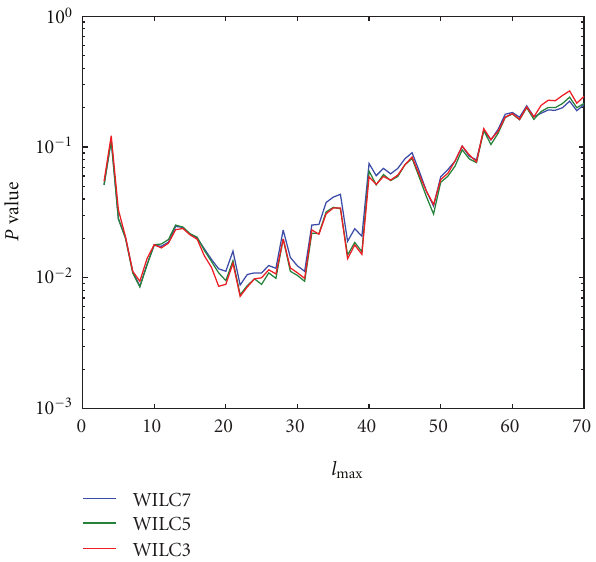
Figure 8: Probability of getting P + /P − as low as the ILC 7-year, 5- year, and, 3-year map at multipole range 2 ≤ l ≤ l max